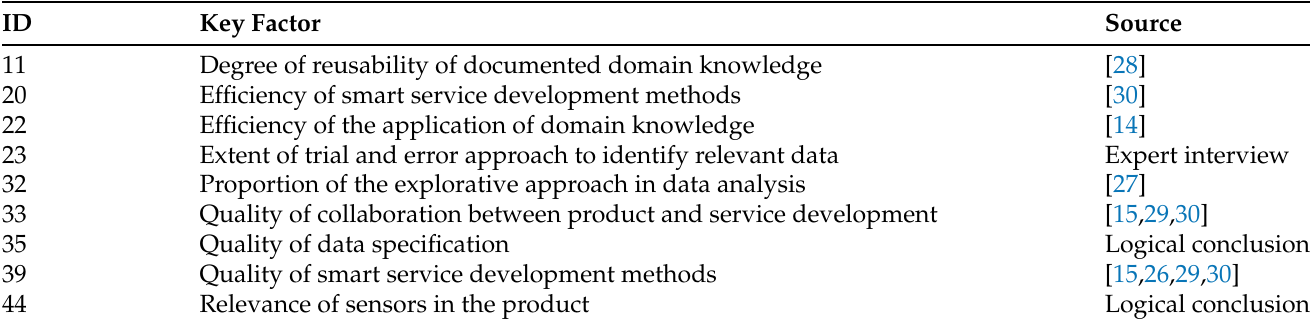
Table A4. Identified key factors for smart service data